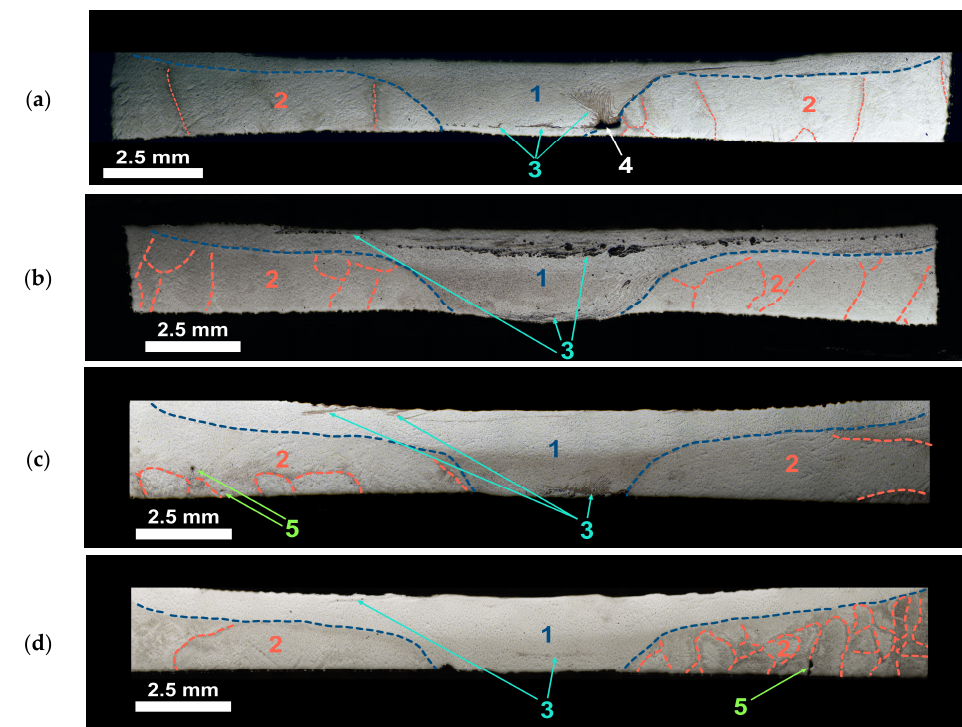
Figure 3. Cross sections of FSP’ed samples of additive Ti-6Al-4V alloy workpieces by modes 1 ( a ), 2 ( b ), 3 ( c ) and 4 ( d ). 1—stir zone; 2—base metal, 3—inclusions of FSW-tool wear product, 4—void, 5—additive manufacturing defects. The dashed lines indicate the boundaries of the stir zone (blue) and the boundaries of the primary β -phase grains in the workpiece material (red).